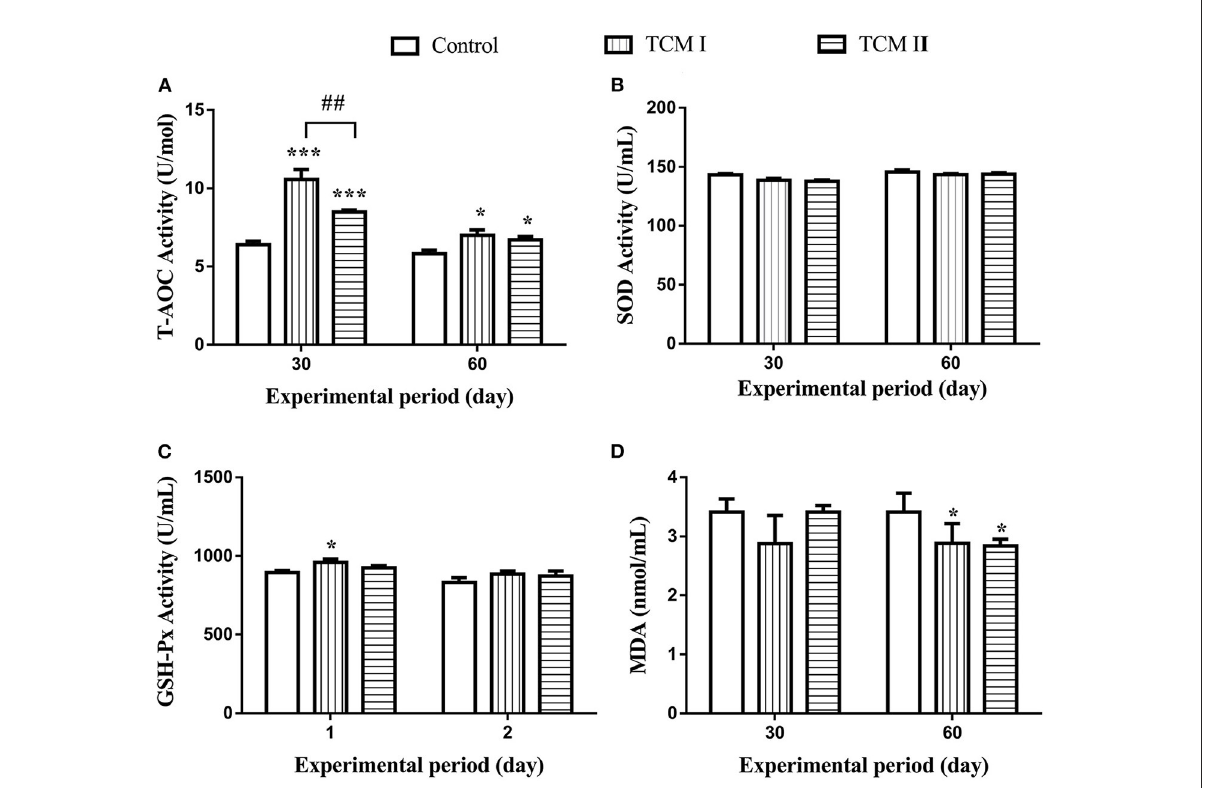
FIGURE1 Determination of (A) T-AOC, (B) SOD, (C) GSH-Px, and (D) MDA levels in serum on days 30 and 60. The data are presented as the mean ± SD of at least three independent experiments ( n ≥ 3). “*” indicates a significant difference compared with control group (* P < 0.05, ** P < 0.01, and *** P < 0.001). “ # ” indicates a significant difference between the indicated groups ( # P < 0.05, ## P < 0.01, and ### P < 0.001). The same scheme also applies to the remaining